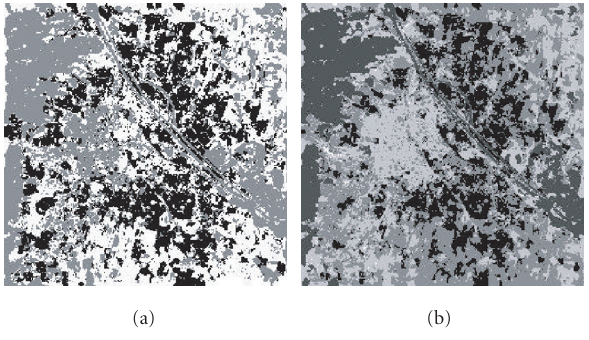
Figure 9: (a) Segmentation given K = 3 and (b) segmentation given K = 5.